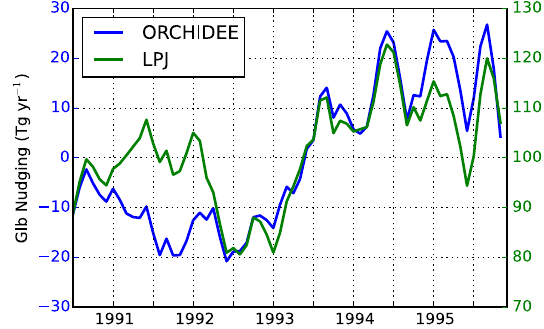
Figure 5. Global deseasonalised CH 4 nudging term for the Base1 (left y axis) and Base2 (right y axis) simulations, using CH 4 wet- land emissions from ORCHIDEE and LPJ,